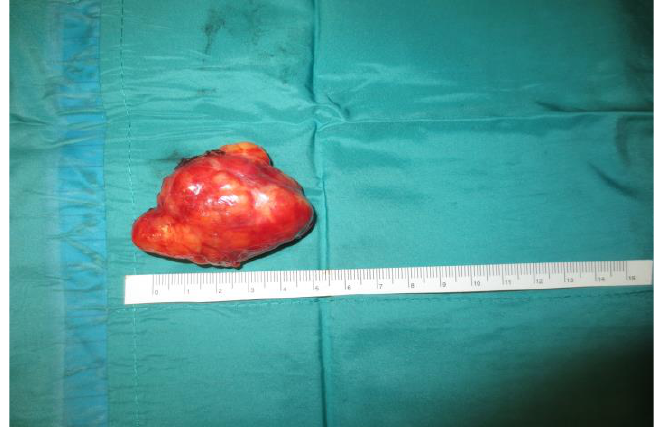
Figure 4. Tumour size and macroscopical features.